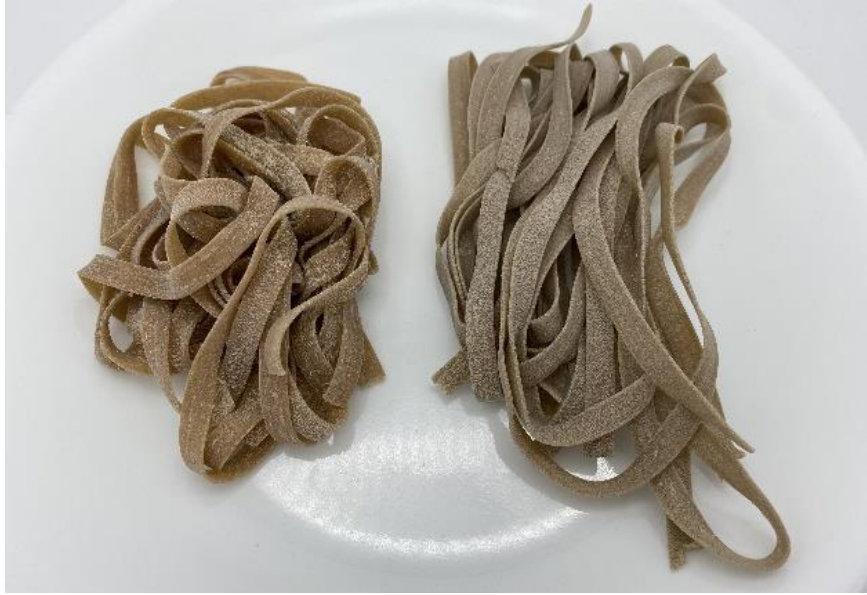
Figure 2. Control ( left ) and CP ( right ) dried pastas.